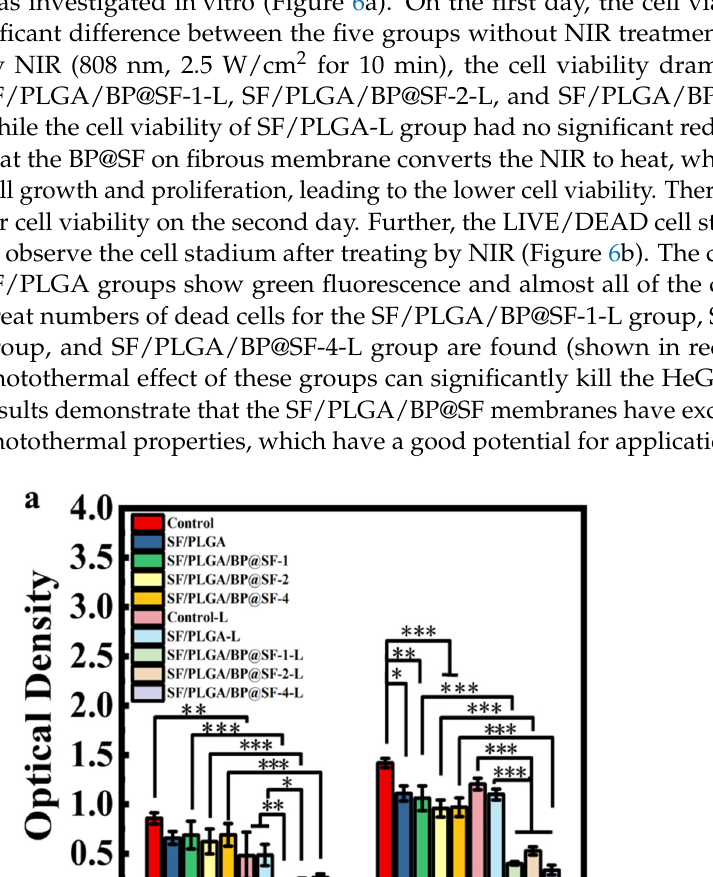
Figure 6. In vitro anti-tumor properties of the electrospun membranes. ( a ) Evaluation of cell viability by CCK-8 assay; ( b ) LIVE/DEAD cell staining of HepG2 cells on the second day of culturing. *P < 0.05, **P < 0.01, ***P < 0.001, data represent means ± SD. 3. Discussion